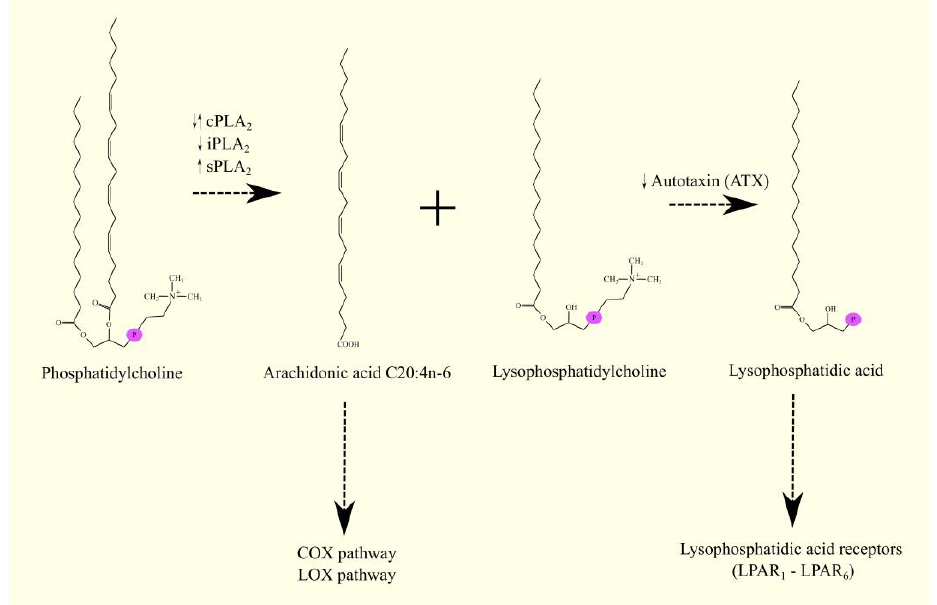
Figure 2. Importance of PLA 2 in metabolism of ARA and production of lipids mediators